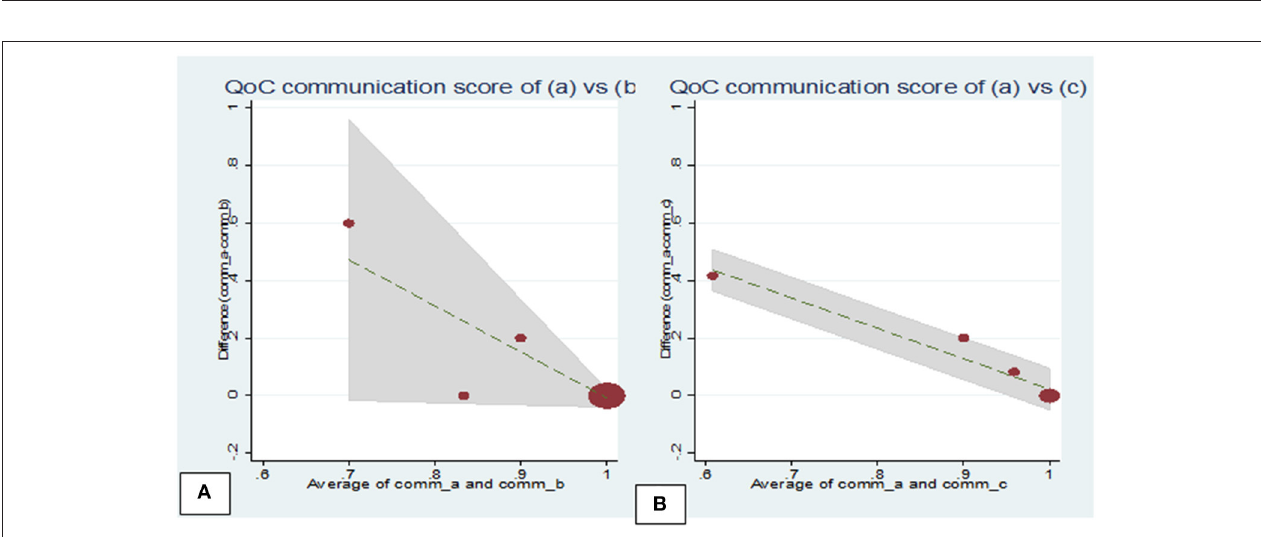
FIGURE 2 | Bland-Altman plots of the mean difference against the mean communication scores assigned by observers during household visits . (A) Plot showing observers (a) and (b) scores, mean diff = 0.07, standard deviation (SD) = 0.19 (limits of agreement = mean − 2 × SD to mean + 2 × SD) = − 0.31 to 0.44; (B) Plot showing observers (a) and (c) scores, mean diff = 0.14, SD = 0.20 (limits of agreement = mean − 2 × SD to mean + 2 × SD) = − 0.25 to